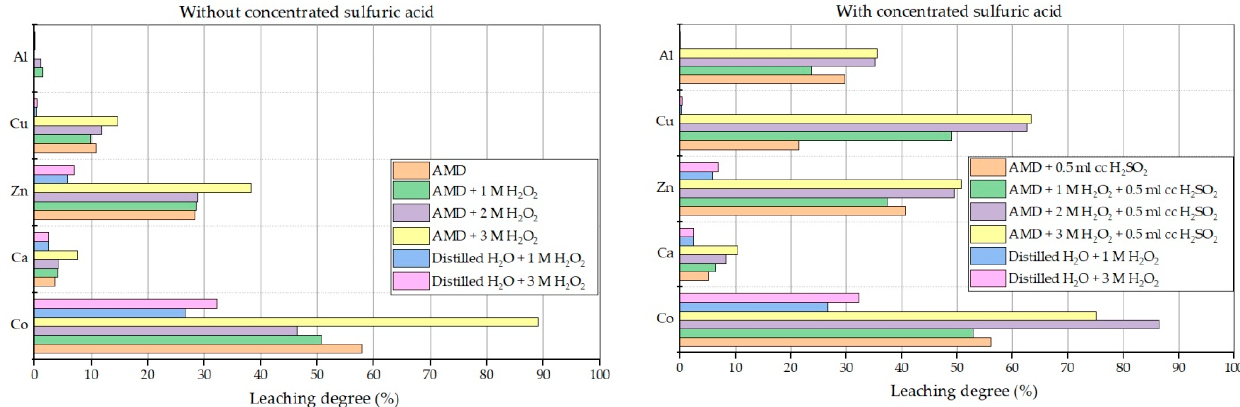
Figure 8. Influence of hydrogen peroxide on AMD leaching without and with concentrated sulfuric acid with reference to hydrogen peroxide distilled water leaching of fine PPCB powder.